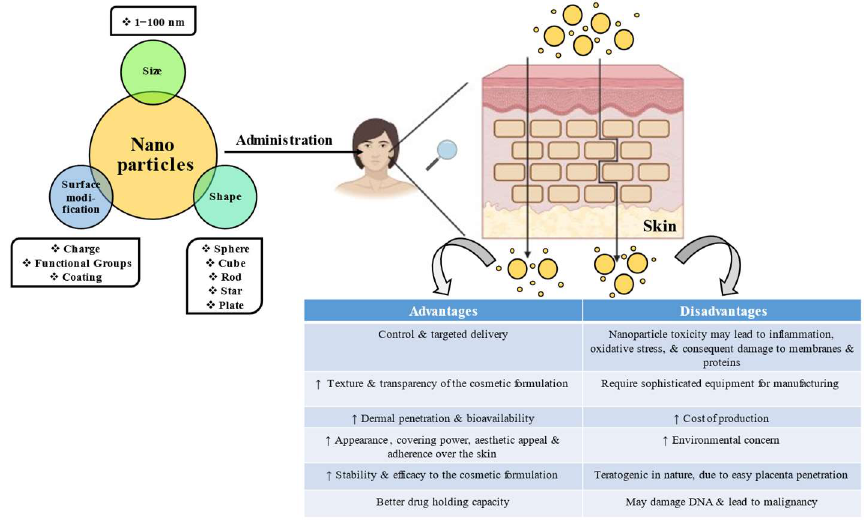
Figure 1. Advantages of